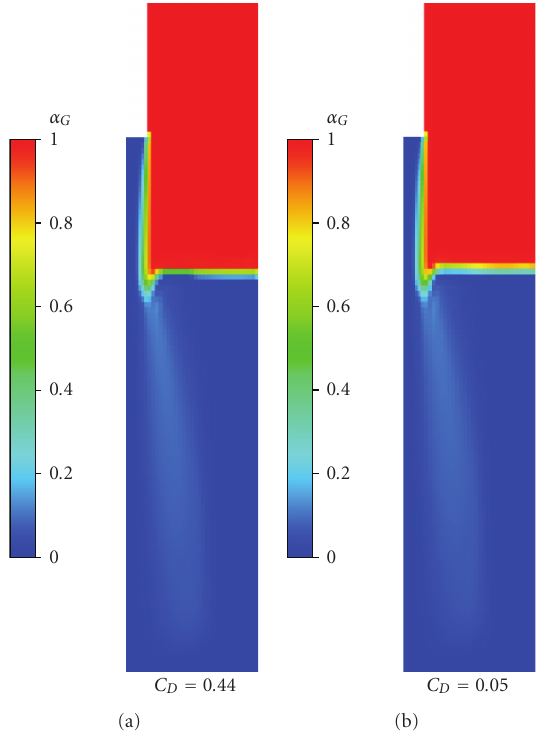
Figure 4: Gas void fraction fields for a simulation using a dispersed phase model for gas homogenous SST turbulence for both